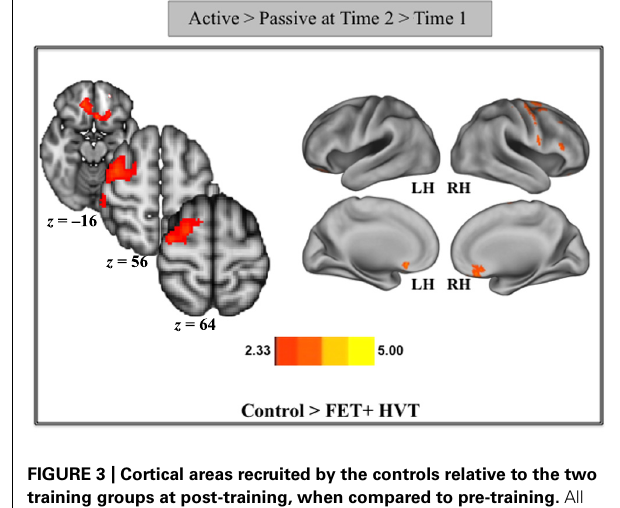
FIGURE 3 | Cortical areas recruited by the controls relative to the two training groups at post-training, when compared to pre-training. All axial slices are presented in radiological orientation.